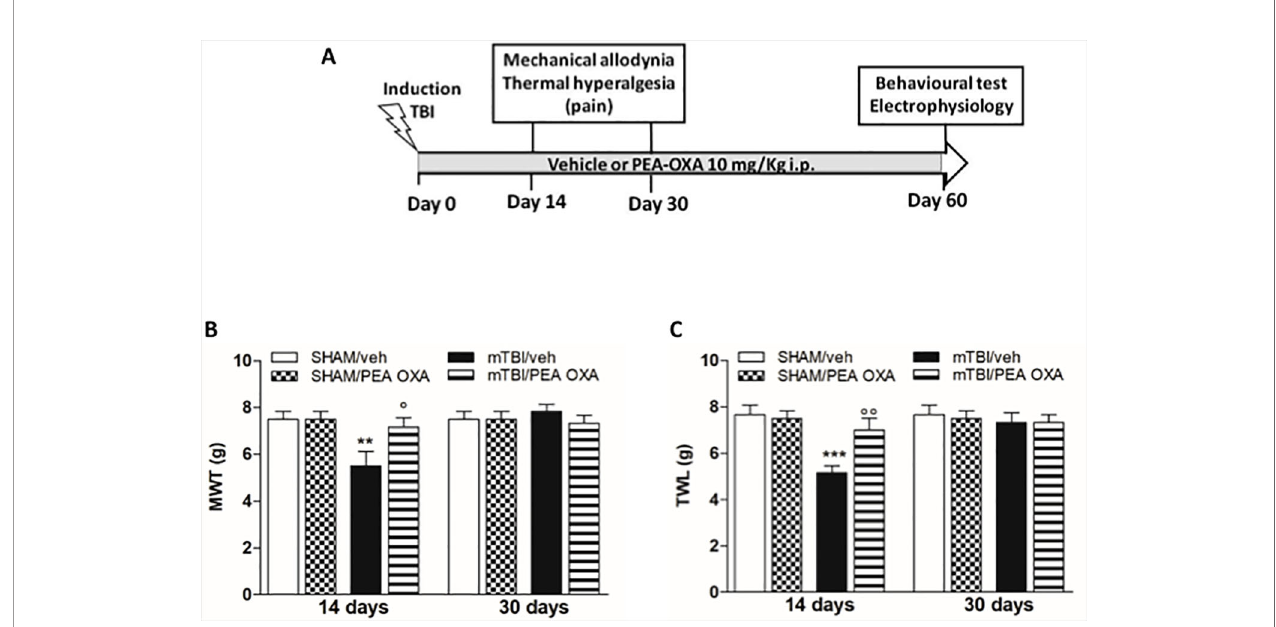
FIGURE 1 | Effects of repeated administration of vehicle (Kolliphor 5%) or PEA-OXA (10 mg/kg, i.p.) on pain behavioral evaluations in sham and mTBI mice. (A) Timeline of the experimental procedure of mild Traumatic Brain Injury (mTBI) induction and related behavioral and electrophysiological characterization in presence of vehicle or PEA-OXA treatment. (B) Mechanical Withdrawal Thresholds (MWT) measured through Dynamic Plantar Aesthesiometer, (C) Thermal Withdrawal Latency (TWL) measured through the plantar test. Data are represented as mean ± SEM of 6 – 8 mice per group. **P < 0.01 and ***P < 0.001 indicate signi fi cant differences compared to SHAM/veh. °P < 0.05 and °°P < 0.01 indicate signi fi cant differences compared to mTBI/veh. P < 0.05 was considered statistically signi fi cant. One-way ANOVA, followed by Bonferroni post hoc test was